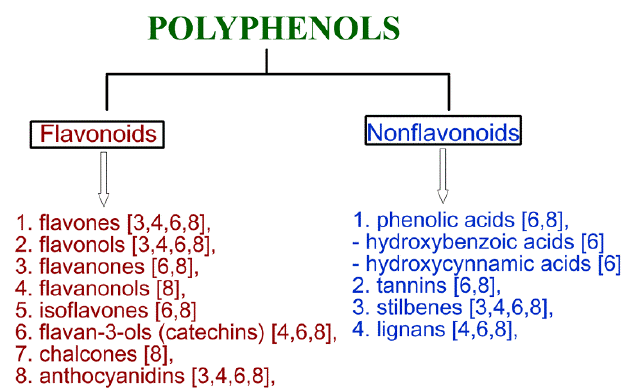
Figure 1. The classification of polyphenols based on their chemical structure.